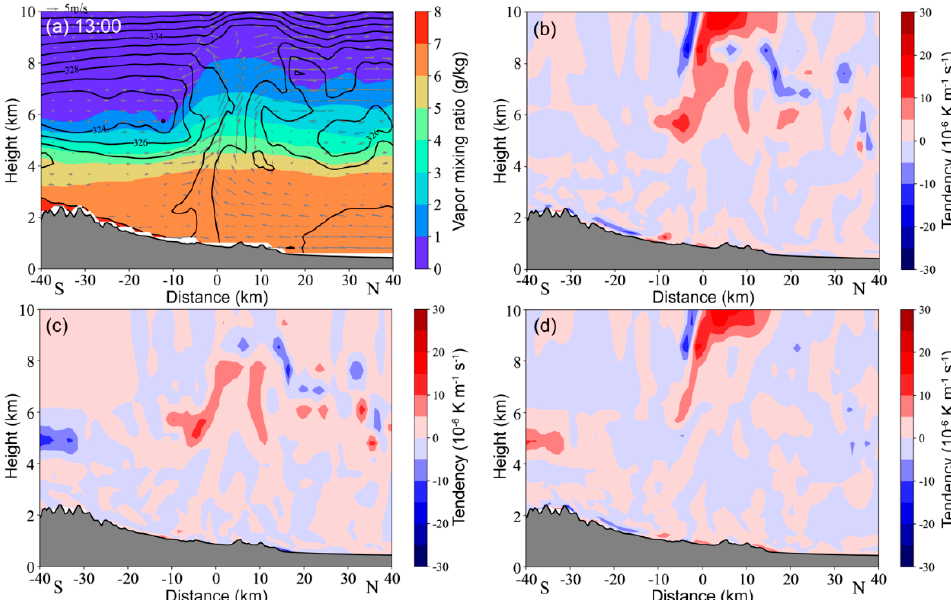
Figure 14. ( a ) Cross − sections of the modeled reflectivity, ( b ) tendency of convective stability, ( c ) vertical wind shear term, and ( d ) divergence term of the convective stability tendency along the west black line in Figure 10.